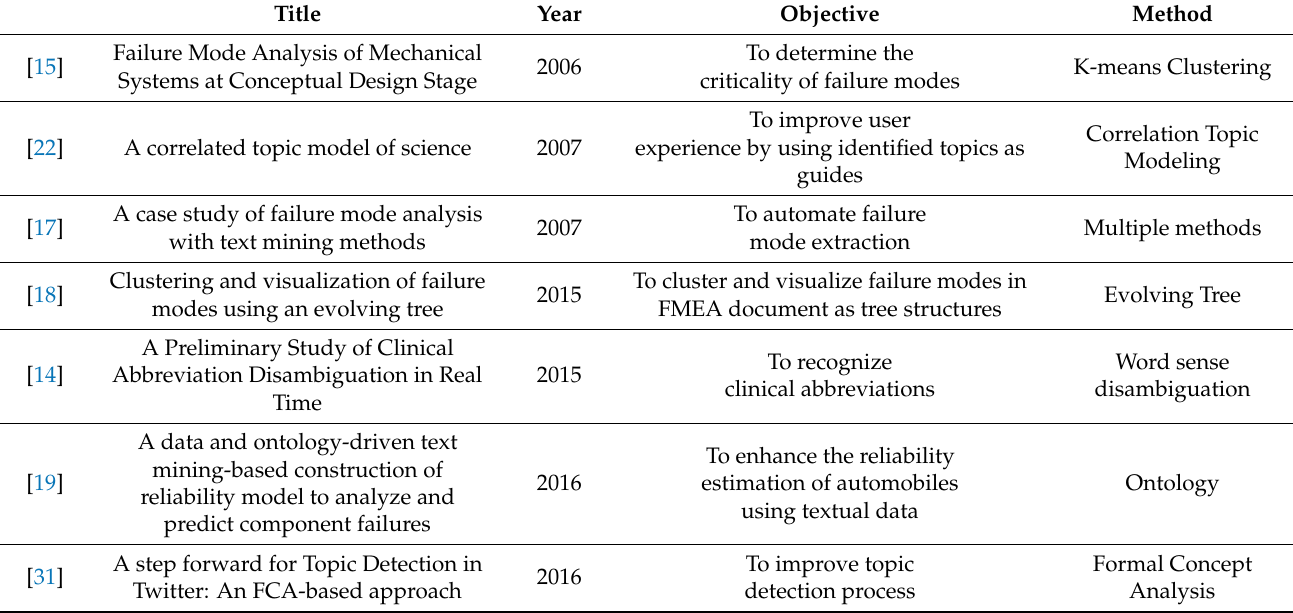
Table 1. Summary of